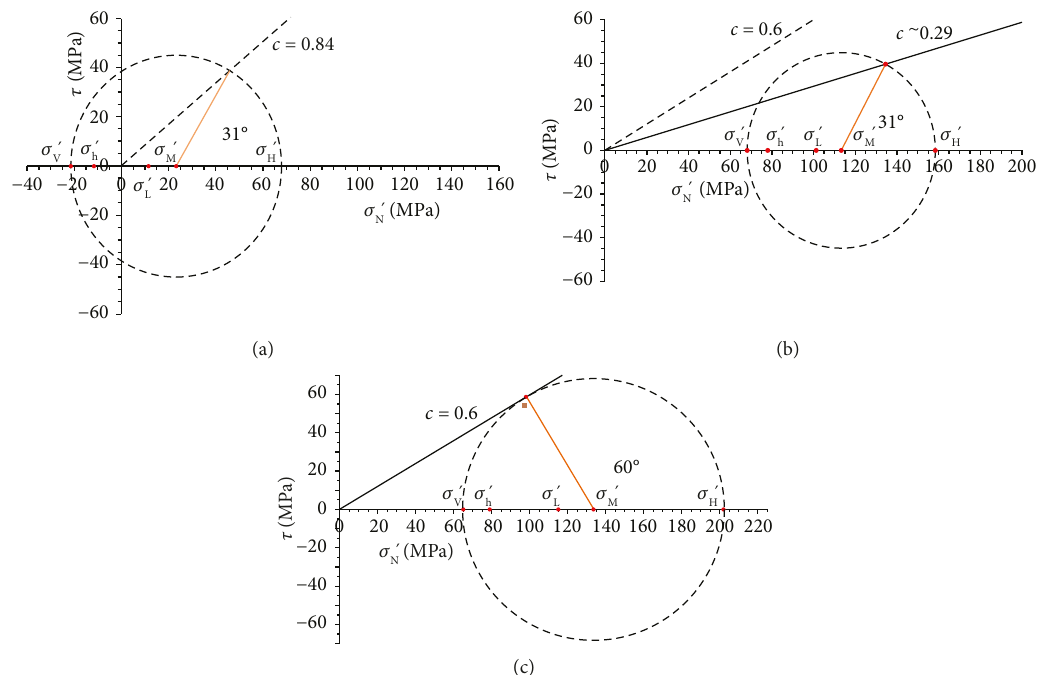
′ , σ ′ , σ ′ , σ ′ , and σ ′ Figure 7: Mohr circle representations of the state of stress estimated on the Namsong Fault. The quantities σ h H V L M ‐ P ‐ P ‐ P ‐ P ‐ P , σ , σ , σ , and σ , where P is the fl uid pressure at the point for which the analysis is denote the e ff ective stresses σ h f H f V f L f M f f ′ to the Mohr circle indicates the orientation — in ≡ σ ≡ σ undertaken, σ + σ + σ /3 , and σ + σ /2 . Inclined line connecting σ L h H V M H V M Mohr circle space — of the pole of the fault. Angles between the maximum principal stress and the normal to the fault plane are labelled (cf. [100, 101]). Failure envelopes are drawn for di ff erent values of the coe ffi cient of friction of the Namsong Fault, c . (a) Stress state represented by a lithostatic σ of 110MPa, with σ = 120MPa and σ = 200 MPa , the latter oriented at an azimuth of 111 ° to provide V h H is set to 132MPa, the peak value during the initial stimulation of well PX-2 in consistency with the focal mechanism in Figure 5(c). P f February 2016 [15]. This diagram indicates that unless c > 0 84 the resulting conditions would have caused this fault to slip. Since such a high coe ffi cient of friction is unlikely, it is concluded that this high fl uid pressure was not transmitted to the Namsong Fault. (b) For the same depth and stress state as (a) except P is set to the hydrostatic value of 42MPa, to represent the conditions after the injection and fl owback f experiments in August-September 2017 and before the November 2017 earthquake. Under these conditions c ~ 0.29 would place the Namsong Fault at the threshold of stability. Also shown for comparison (dashed) is a failure envelope for c = 0 6 , a representative value for a fault in granite that is una ff ected by alteration to authigenic minerals (e.g., [64]). (c) Preferred stress state from [5] for 4200m depth, of 106MPa, with σ = 120MPa and σ = 243 MPa , the latter oriented at an azimuth of 083 ° . Under these represented by a lithostatic σ V h H conditions, c = 0 6 would place the Namsong Fault at the threshold of stability for slip in the oblique sense indicated in the focal mechanism in Figure 5(d). A similar plot to this is provided in [5] (their Figure O-11), in which principal stresses of the same magnitudes are oriented slightly di ff erently, with σ at an azimuth of 077 ° rather than 083 ° . With this adjustment, the focal mechanism in Figure 5(d) is consistent H ′ ~ 97MPa and τ ~ 54MPa; this stress state plots near the threshold for slip for c = 0 6 (square symbol in the fi gure), as was noted in with σ N